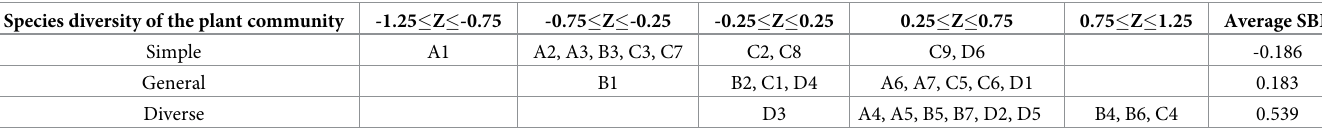
Table 5. SBE scores of samples based on the species diversity of the plant community. Species diversity of the plant